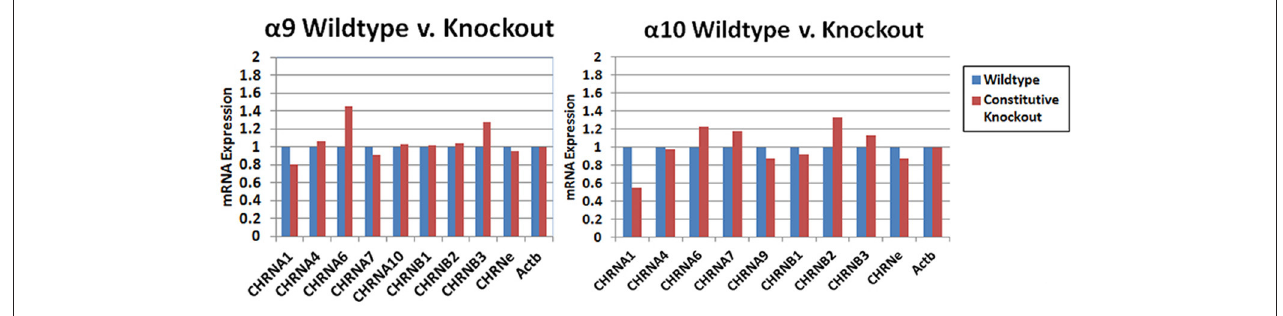
FIGURE 9 | PCR arrays. Whole cochlear tissue was combined from four animals and the expression levels were determined with a custom Nicotinic Acetylcholine Receptor Qiagen RT 2 Profiler TM PCR array. The transcripts for the α 9 and α 10 subunits in wild type mice were verified by sequencing. The small amount of product that was recognized by the primers in the KOs was also sequenced and were multiple irrelevant transcripts. There was no obvious change in transcription level of the other nAChRs that were detected in the cochlear tissues with this